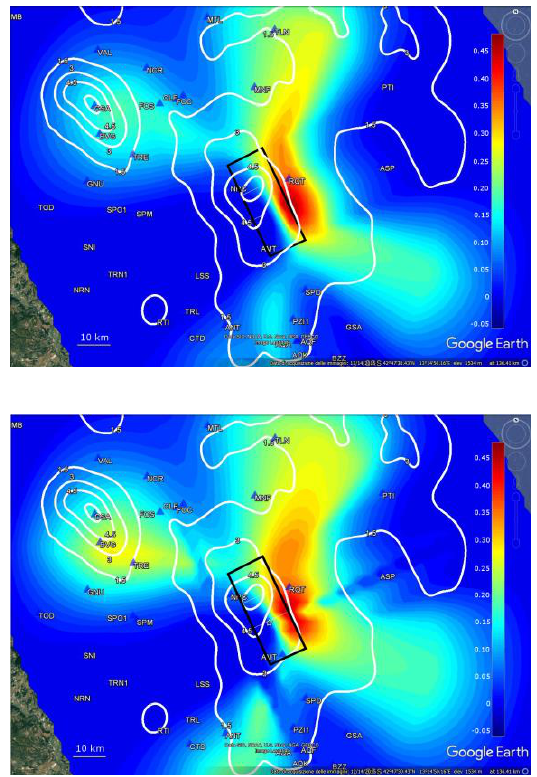
Figure 3: fD resulting from Eq. (2). Model 1 (top): Constant rupture velocity and constant Vs result- ing in Mach = 0.8; Model 2 (bottom): variable rup- ture velocity and depth variable Vs profile (Table 2). Shakemaps results (from the peak horizontal value of 5% critically damped pseudo-acceleration, %g) are presented in white